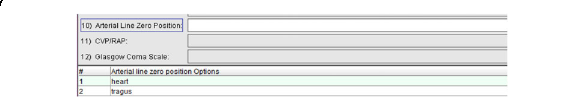
Fig. 1 (abstract 001714). showing the ‘’ drop-down list ’’ of arterial transducer position in our electronic patient observation